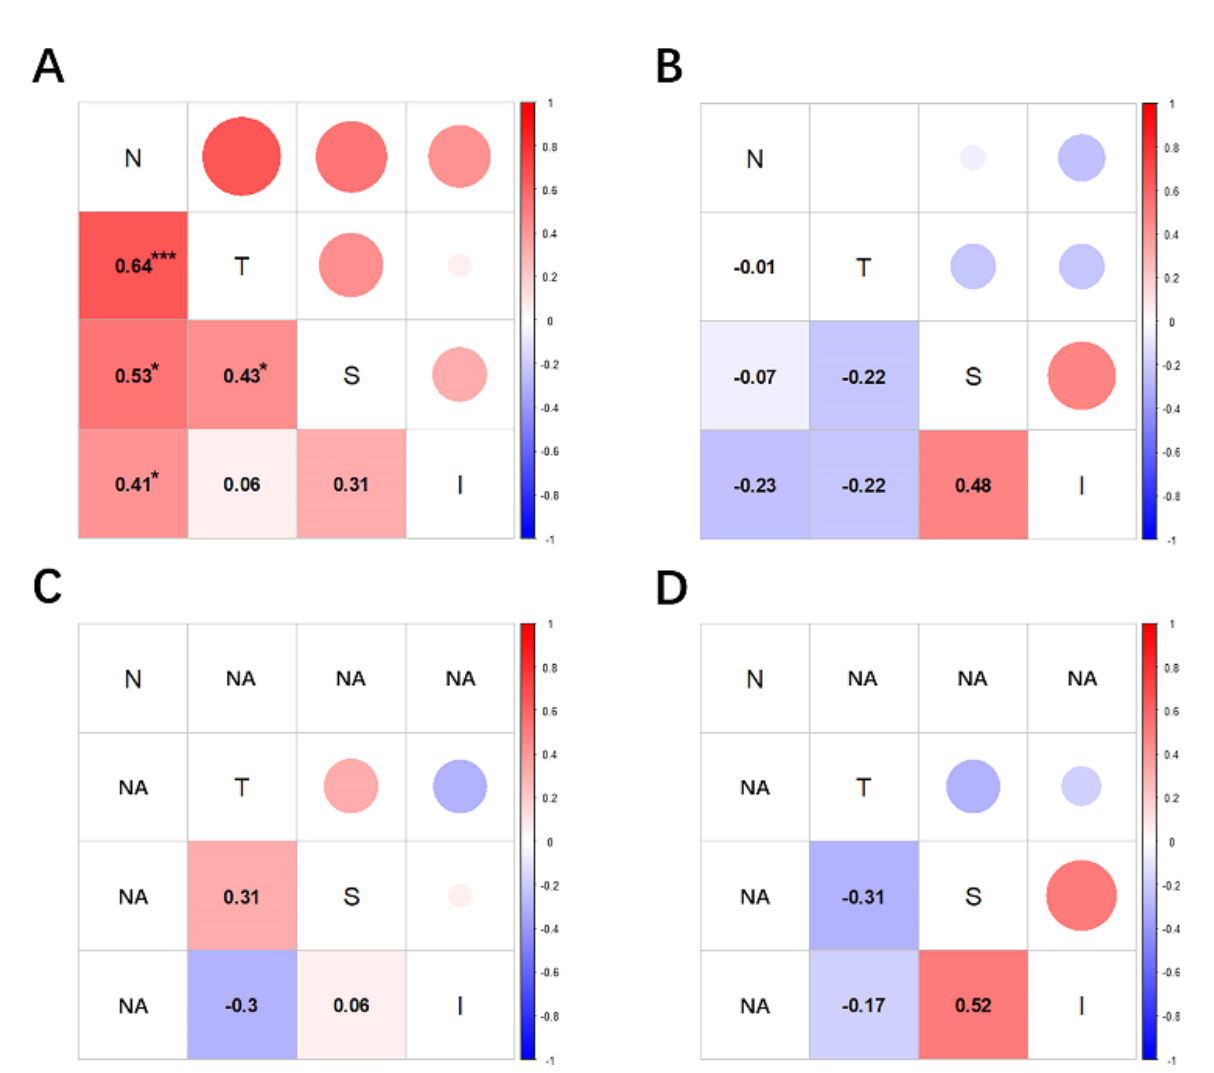
Figure 3. Spearman correlations among palisades of Vogt epithelial thickness/Bowman’s membrane epithelial thickness (POV-ET/BM-ET) values of quadrants of each group are shown. Red indicates a positive correlation, blue indicates a negative correlation, and increasingly dark colors indicate in- creasingly significant correlations. ( A ): Correlations between POV-ET/BM-ET and age among Group I, the only one of the four groups considered in which the correlation was observed. ( B ): Correlation between POV-ET/BM-ET values and age among Group II. ( C ): Correlation between POV-ET/BM-ET and age among Group III. ( D ): Correlation between the POV − ET/BM − ET and age among Group